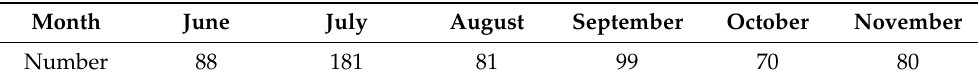
Table 1. The number of occurrence records of the Pacific sardine by month from 2015 to 2020. Month